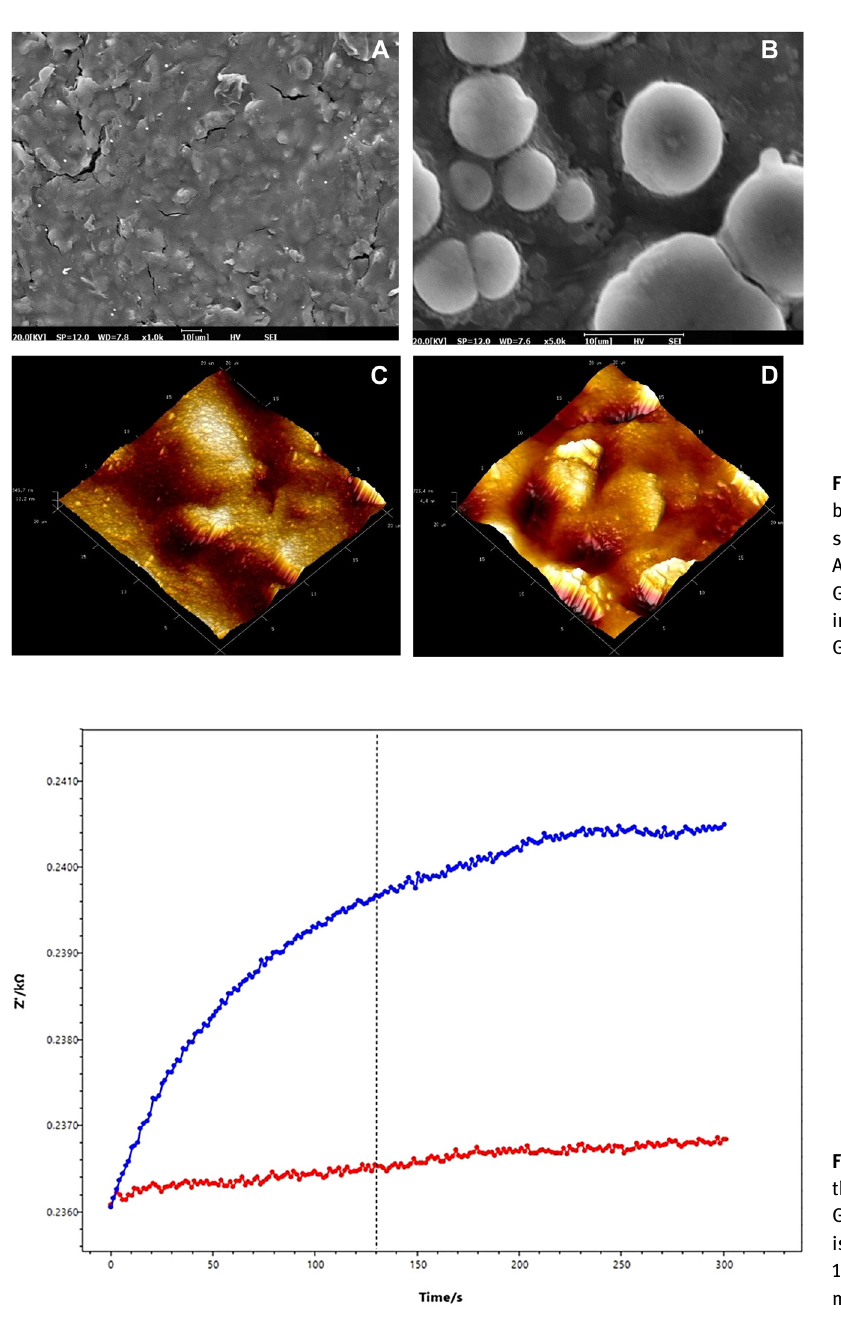
Figure 3: Chronoimpedance measurement of the LNCaP biosensor. (Red display is GNPE-Apt biosensor in serum, Blue display is GNPE-Apt biosensor at a concentration of 1 cell/mL LNCaP). The optimum measure- ment time is found to be 130